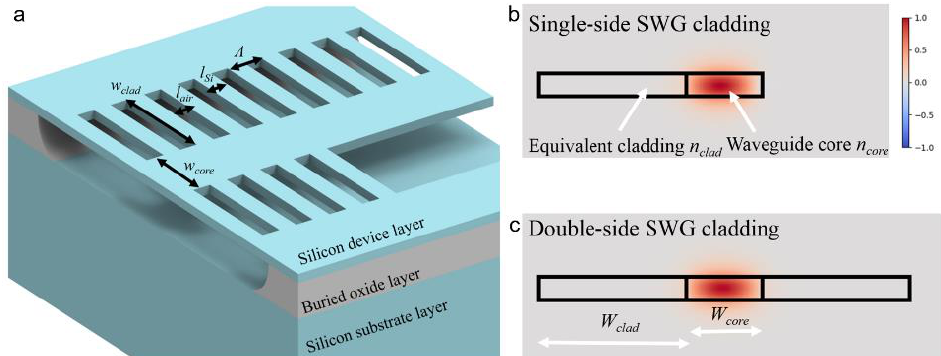
Figure 1. ( a ) Schematic of the suspended waveguide structure. ( b ) Mode profile ( H y ) of the suspended waveguide with single-side cladding. ( c ) Mode profile ( H y ) of the suspended waveguide with double-side cladding.